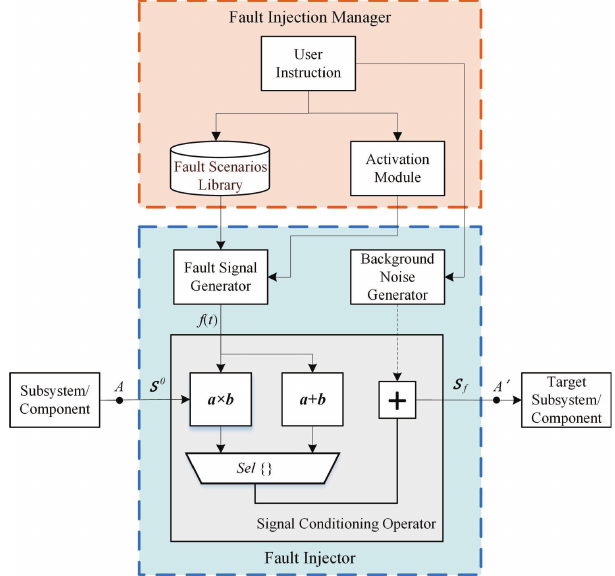
Figure 2. The framework of the signal-based FI